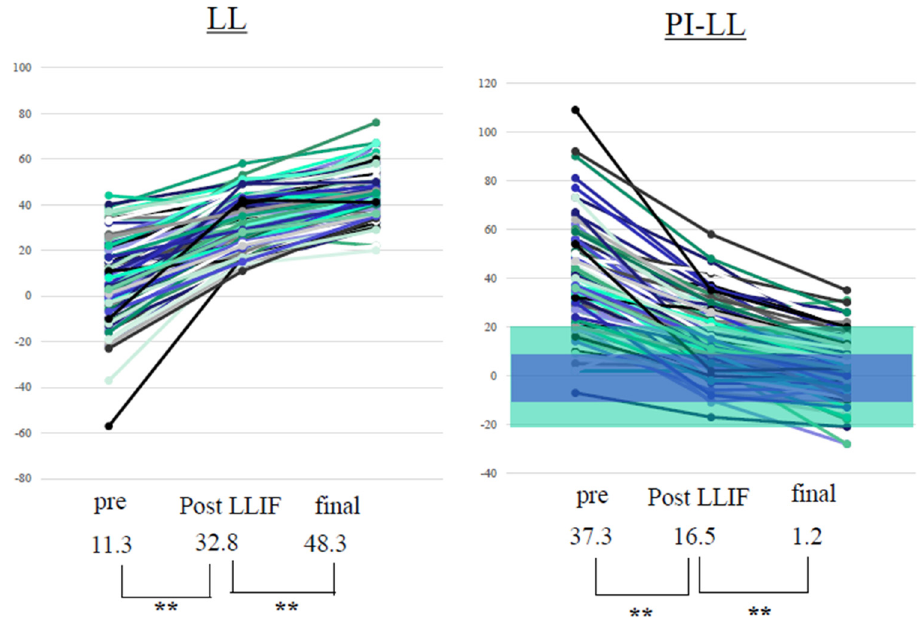
Figure 2. Preoperative and postoperative LL and PI-LL. Values are presented as mean ± standard deviation. Wilcoxon signed-rank test. ** Statistically significant. PPS improved LL by 15.5° (4–42°). After CMIS, 60% of all patients met PI + 10° ≥ LL ≤ PI − 10° (blue range) and 90% met PI + 20 > LL > PI − 20 (green range). LL: lumbar lordosis; PI: pelvic incidence; PPS: percutaneous pedicle screw; LLIF: lateral lumbar interbody fusion. ** p < 0.001.